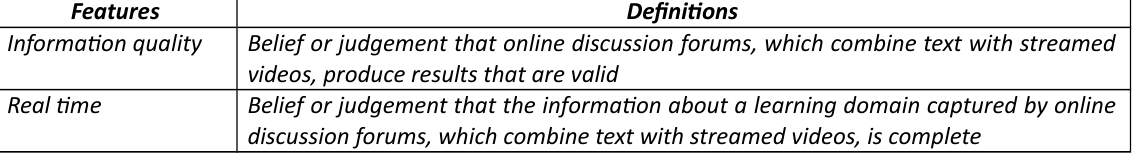
Table 3. Fourth set of features and their